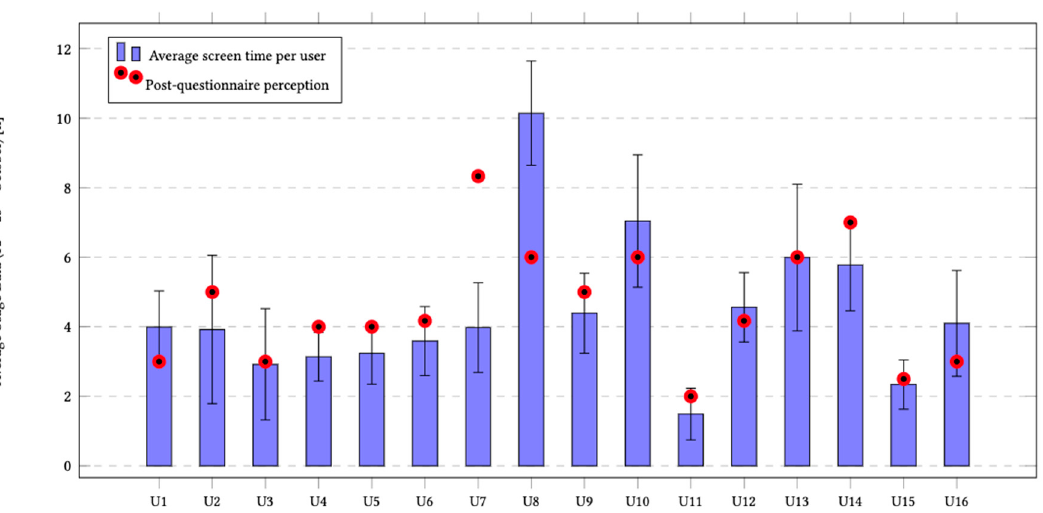
Figure 7. Average usage data, for each user, filtered by day, compared with perception after filling the post-questionnaire.